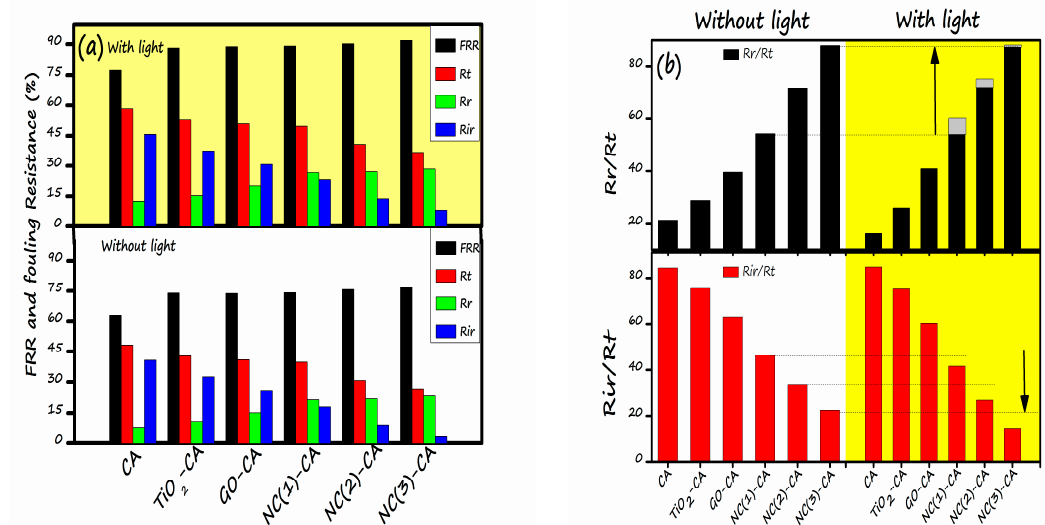
Figure 14. ( a ) Influence of light on FRR and fouling resistances of various membranes ( b ) Influence of light on the ratio of reversible fouling and irreversible fouling to total fouling of various membrane.